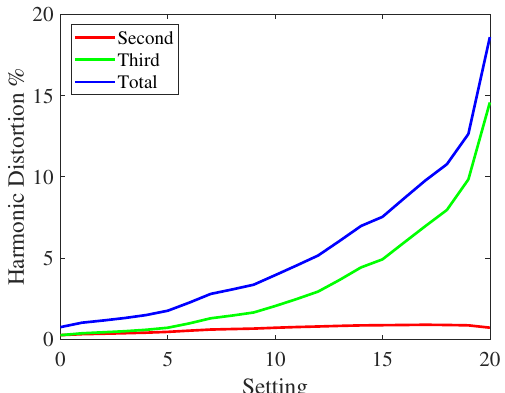
Figure 10. Second, third, and total harmonic distortions of the Electro Harmonix East River Drive pedal at the different settings.